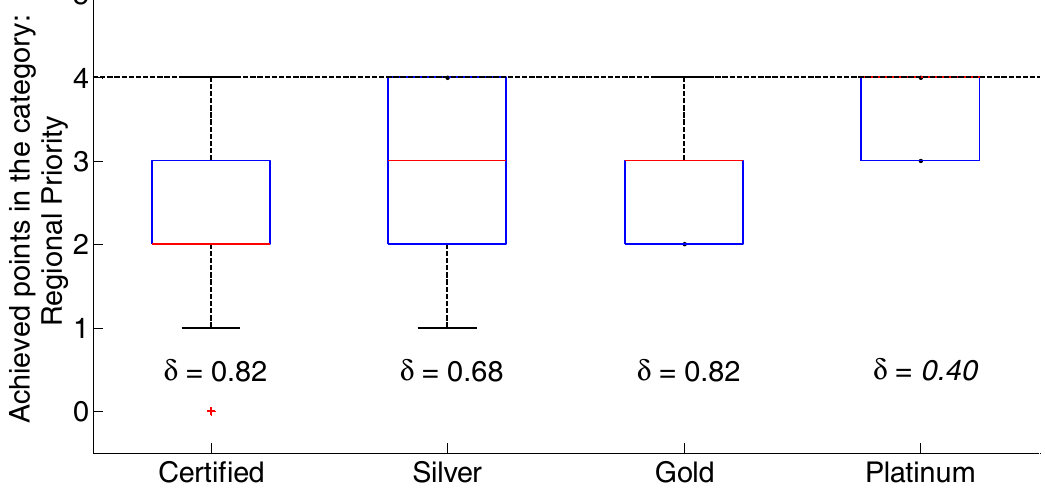
Figure 9. Boxplot results and Cliff’s δ effect size between possible and achieved points in the Regional Priority (RP) category. Effect size is considered to be: very high if | δ | < 0.147 (bold font), high if 0.147 < | δ | < 0.33 (bold italic font), medium if 0.33 < | δ | < 0.474 (italic font), and low if | δ | ≥ 0.474 (normal font).